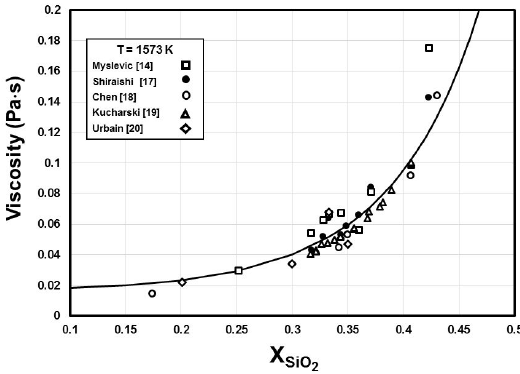
Figure 2. Calculated (line) and experimental (points) viscosities at 1573 K of SiO −FeO melts. 2